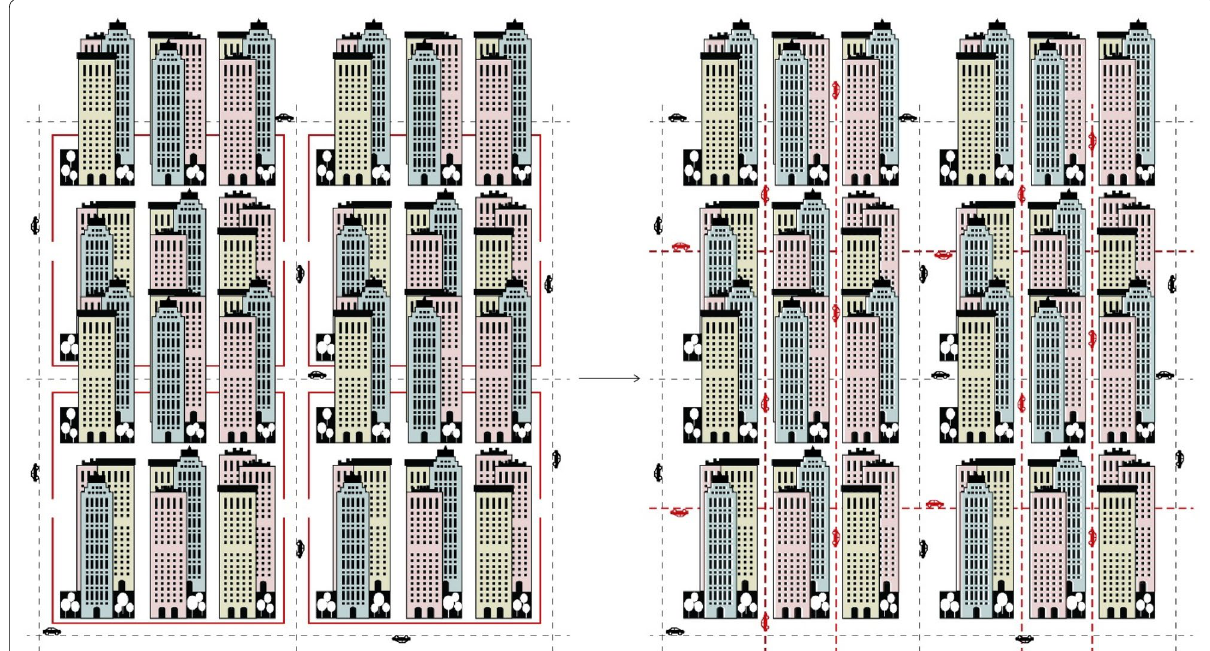
Fig. 4 Open-up the gates: the aim of the new directive is to add a new layer of roads within the currently enclosed superblocks (Source: Hamama 2017)